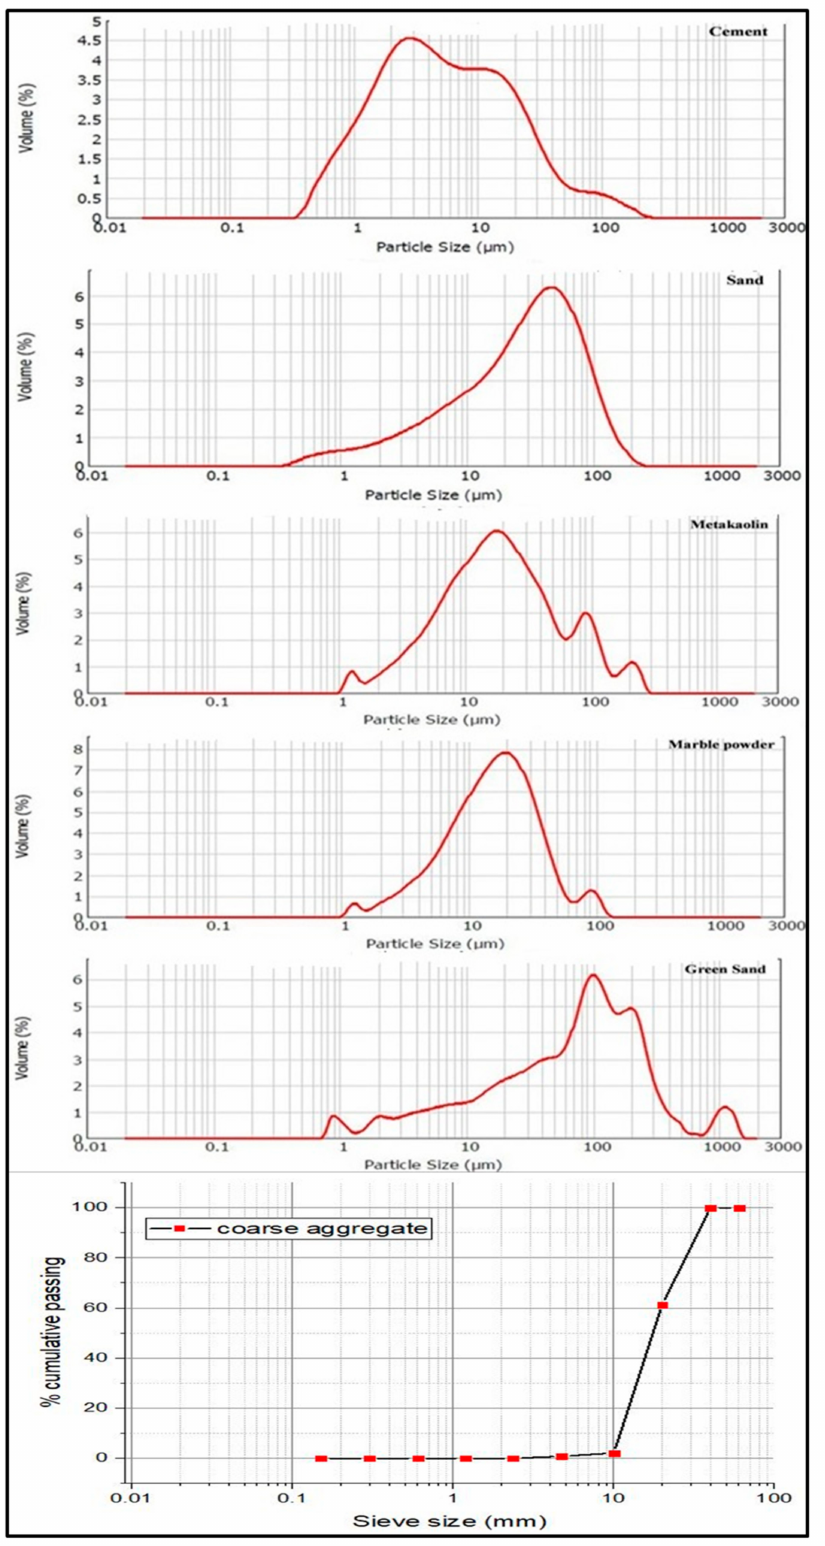
Figure 1. Particle size distribution of materials used in